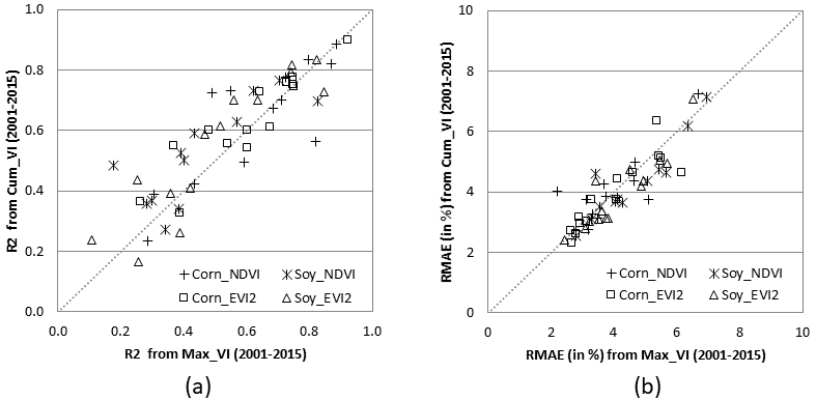
Figure 9. Comparison of R 2 ( a ) and RMAE ( b ) from small cumulative (day 192–236) and maximum VIs for corn and soybeans from 2001–2015. Each point shows statistics for one year (2001–2015) from 20 counties. Statistics that are not significant ( p -value < 0.05) from both Max_VI and Cum_VI are excluded.